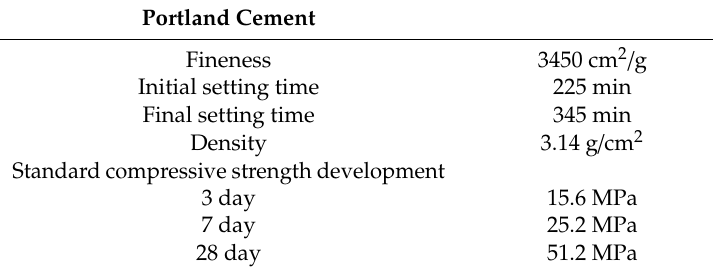
Table 2. Properties of Portland cement provided by